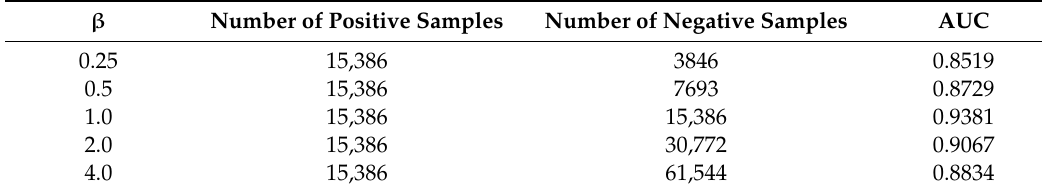
Table 3. Di ff erent β in negative sample